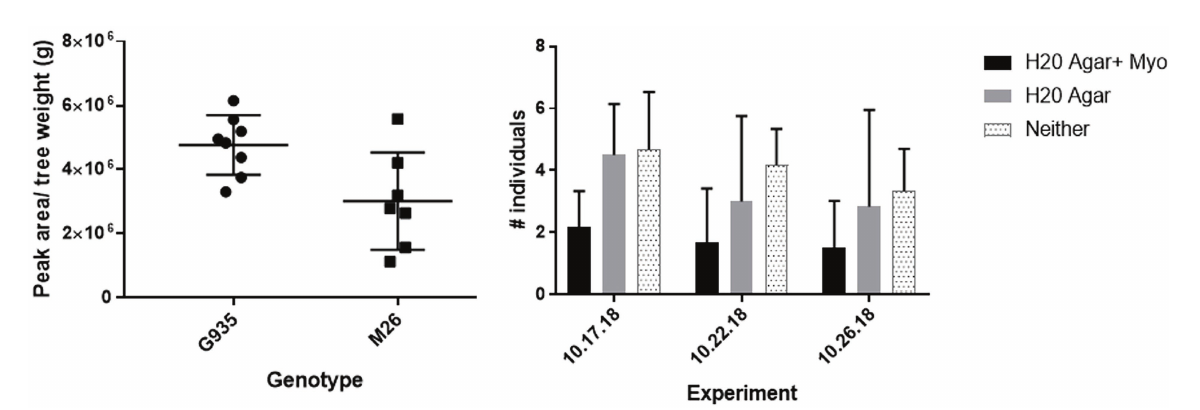
FIGURE 2 Left panel: relative quantity of myo-inositol as determined by LC–MS QTOF analysis (Leisso et al., 2017) in root exudates of micro-propagated G.935 and M.26 plantlets cultivated in root elongation medium (Yepes and Aldwinckle, 1994). Quantity of myo-inositol detected was significantly ( p = 0.0289) greater in exudates of G.935 than M.26 rootstock. Right panel: relative chemotactic response of Pratylenchus penetrans to water agar, water agar + myo-inositol or neither as assessed in in vitro choice assays. Assay was conducted in triplicate with ten adult P. penetrans used in each replicate trial. The number of P. penetrans attracted to the myo-inositol treated agar plug was significantly ( p < 0.03) lower than that toward the water agar alone or numbers migrating toward neither agar-based